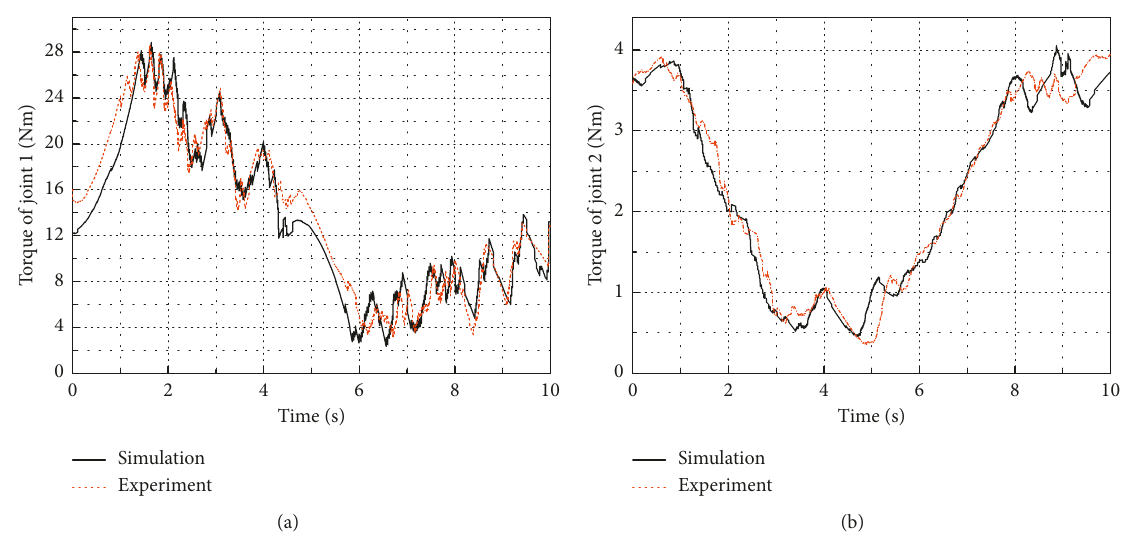
Figure 13: (a) Torque of joint 1. (b) Torque of joint